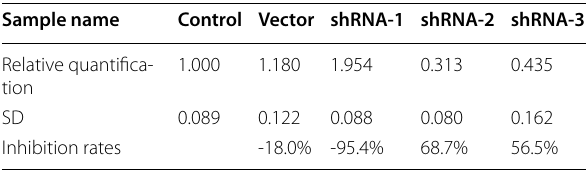
Table 5 Inhibition of NDUFV2 gene silencing on the proliferation of SMMC-7721/ADR cells: the relative quantitative and inhibition rate of NDUFV2 in each group of SMMC-7721/ADR x ± s , n =